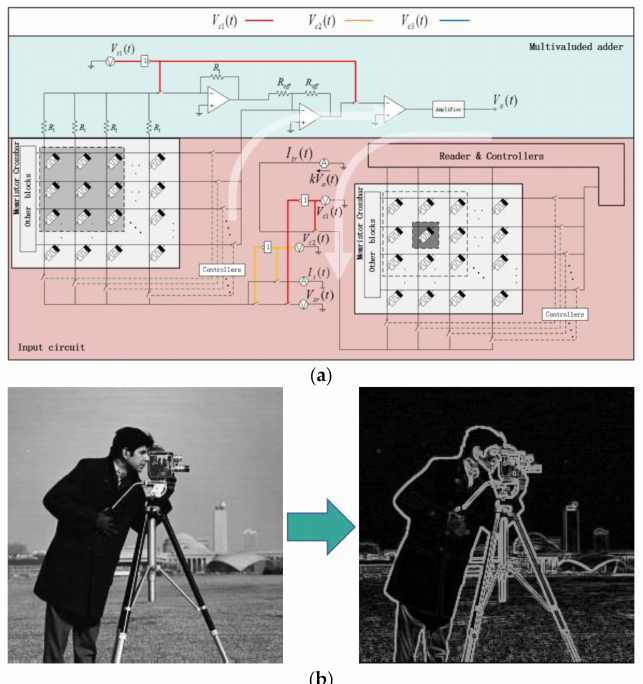
Figure 10. The application of mask circuit based on memristor crossbar array in edge extraction. ( a ) memristor crossbar array; ( b ) image edge extraction